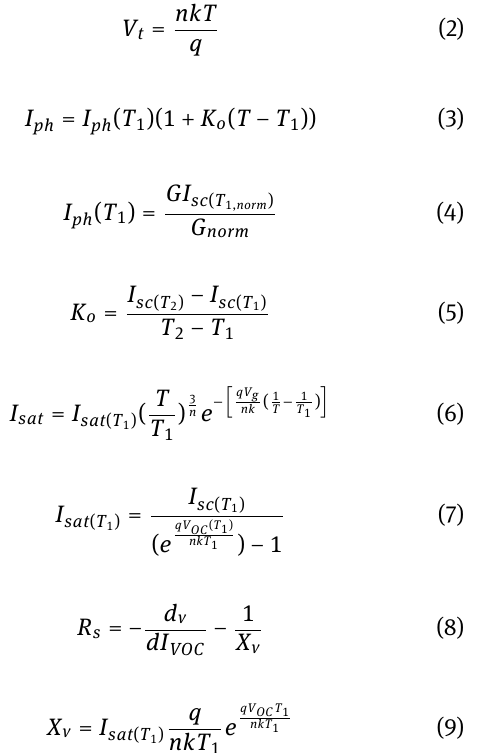
Figure 8: Schematic diagram of the grid-connected HRES system.